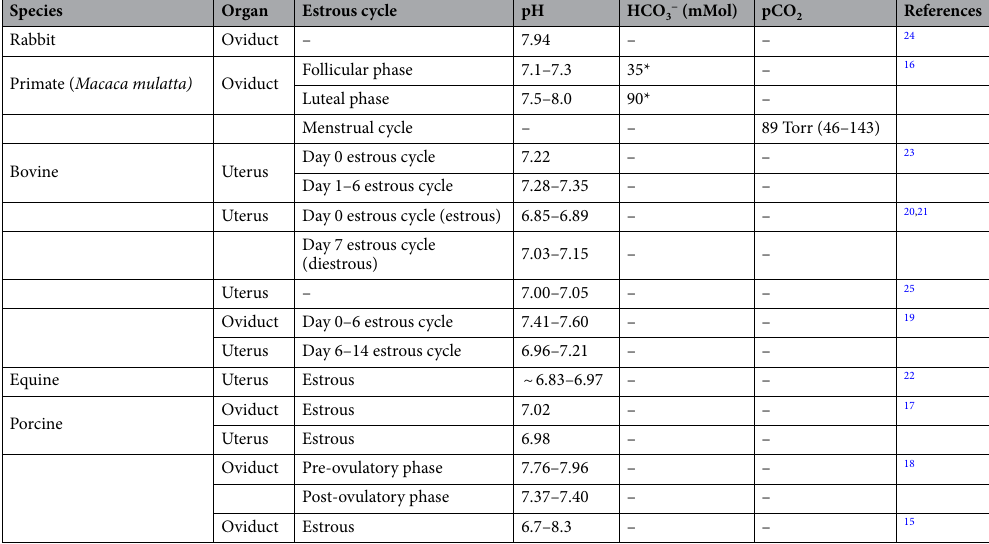
Table 1. Summary of the studies measuring pH, CO 2 and/or HCO 3 − levels directly in the female genital tract (uterus and/or oviduct) of different species. *Calculated from CO 2 and pH